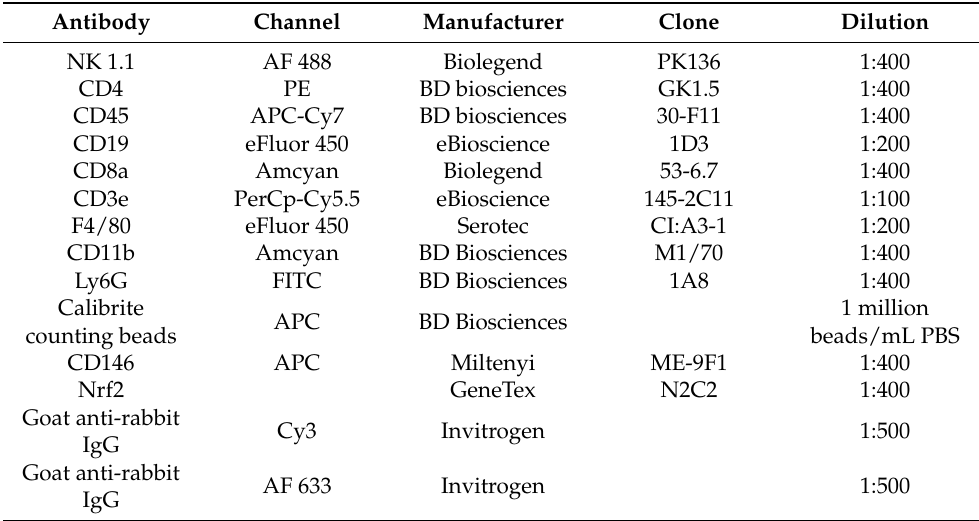
Table 1. Antibodies used in this